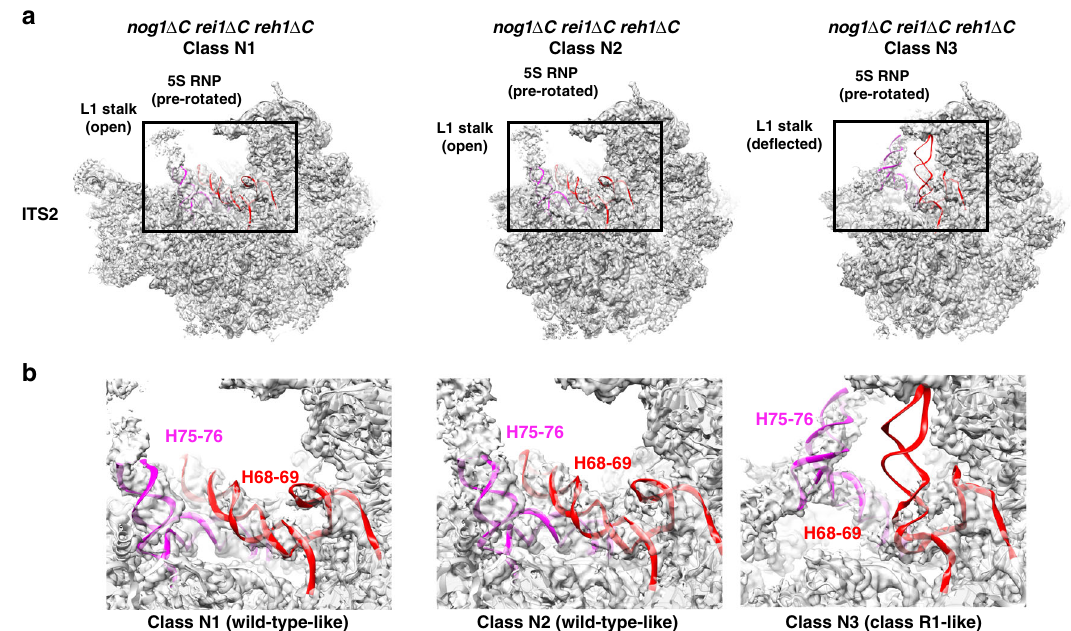
Fig. 6 A minority of nog1 Δ C rei1 Δ C reh1 Δ C mutant pre-60S particles display aberrant rRNA conformations. a Densities of classes N1 – N3 of nog1 Δ C rei1 Δ C reh1 Δ C mutant particles solved at a resolution of 3.0 – 6.0 Å. Classes N1 and N2 are aligned with the atomic model of class R2, while class N3 is aligned with the atomic model of class R1. Note that ITS2 is missing from classes N2 and N3. b View of H68-69 (red) and H75-76 (magenta) from classes N1 –